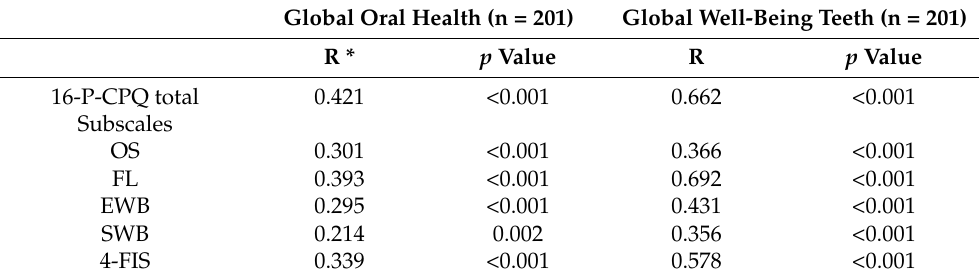
Table 5. Correlation between global perception questions and the 16-P-CPQ total, subscales and 4-FIS.